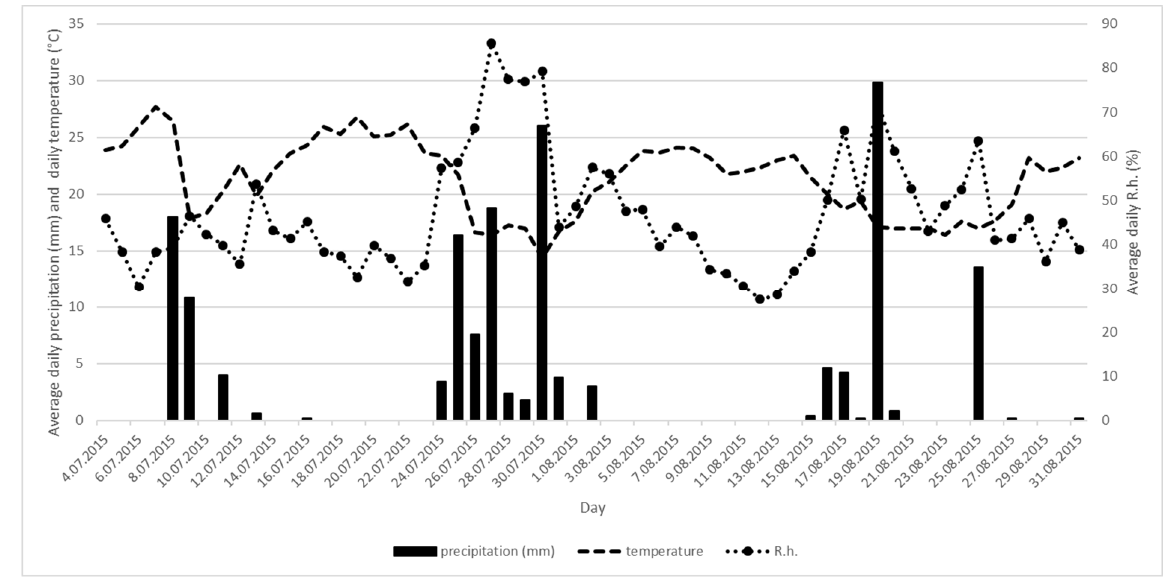
Figure 4. Average daily precipitation, average daily temperature and average daily R.h. (from 4 July 2015–31 August 2015).